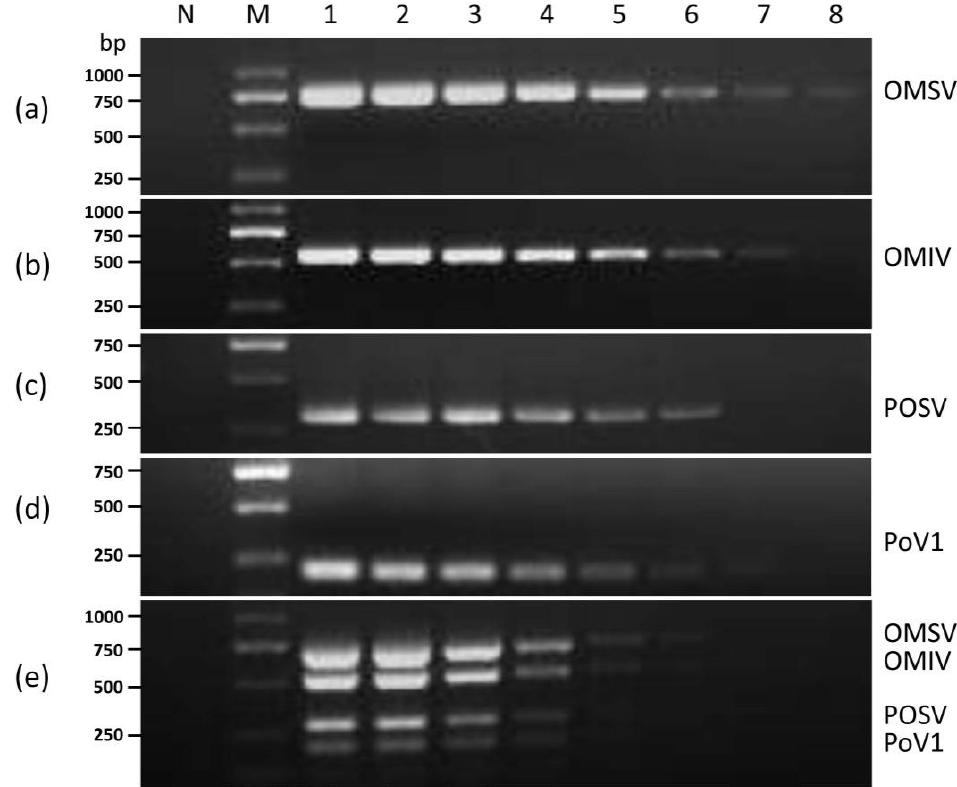
Figure 1. Optimization of the annealing temperature on uniplex RT-PCR detection of ( a ) OMSV (672 bp); ( b ) OMIV (540 bp); ( c ) POSV (310 bp); ( d ) PoV1 (200 bp) and ( e ) multiplex RT-PCR assay. N, negative control, the healthy P. ostreatus sample. Lane M: GL DNA Marker2000. Lanes 1–8, 60.0, 61.0, 62.3, 64.0, 66.3, 68.1, 69.3, 70.0 °C.